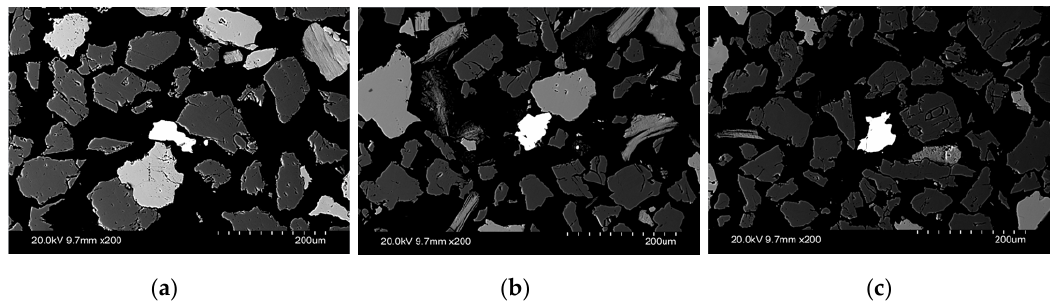
Figure 11. Liberated tantalum-rich particles observed in back-scatter electron images of the particle size fraction < 0.063 mm after a compression ratio of ( a ) 10%, ( b ) 20%, and ( c ) 30% respectively.